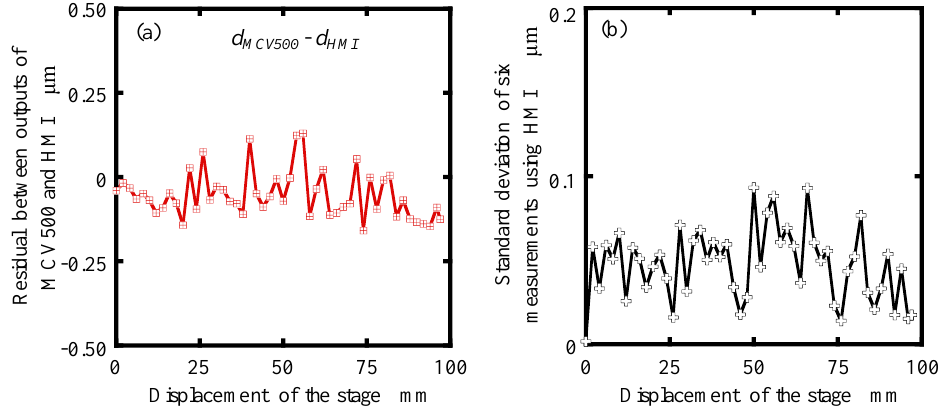
Figure 13. ( a ) Residual between the MCV500 and proposed MHI; ( b ) standard deviation of six displacement measurements by MHI.